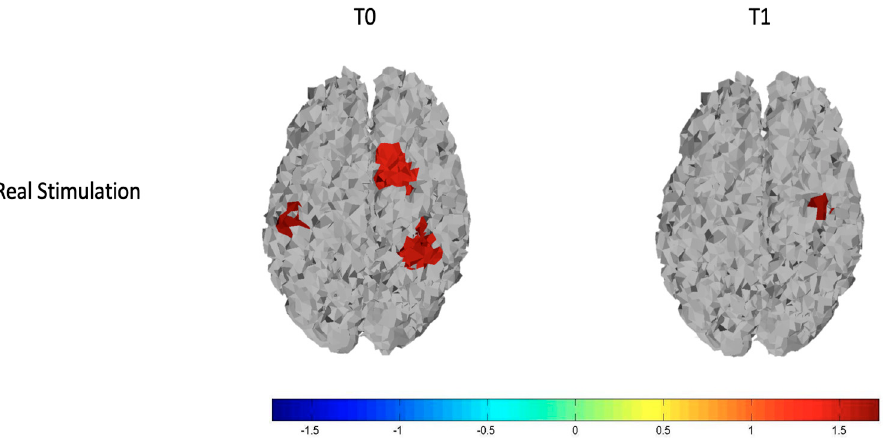
Figure 5. T-statistic map of the brain regions wherein there are significant differences in oxyhemoglobin for the comparisons of controls vs. patients at T0 (on the left ) and controls vs. patients at T1 (on the right ). Red and brown colors express significant oxyhemoglobin increase in controls evaluated with an unpaired Student’s t -test. The scale refers to t values.